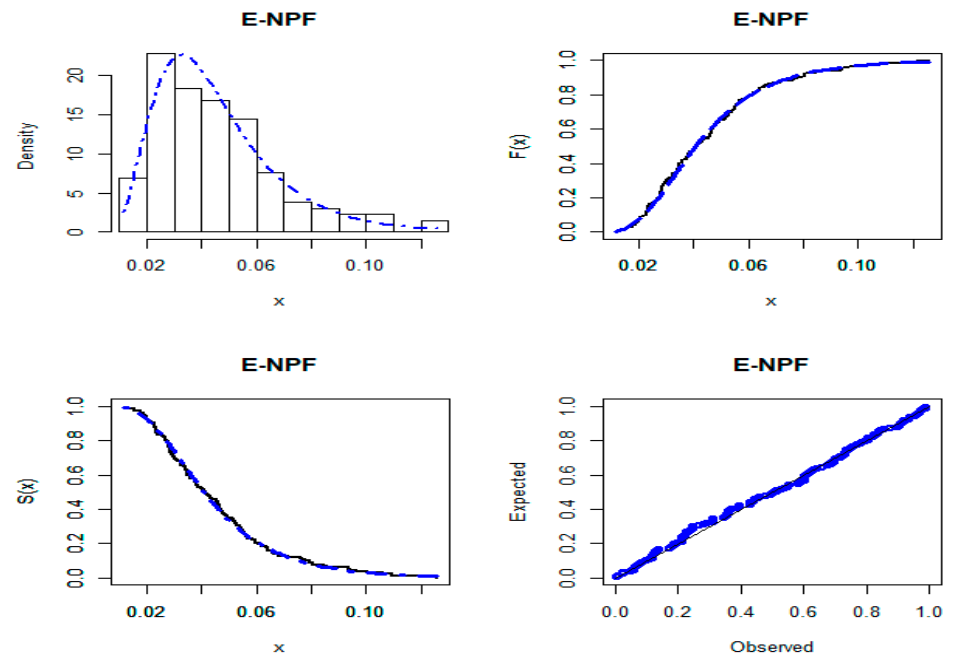
Figure 6. Curves of the E-NPF distribution for SAR image modeling data.